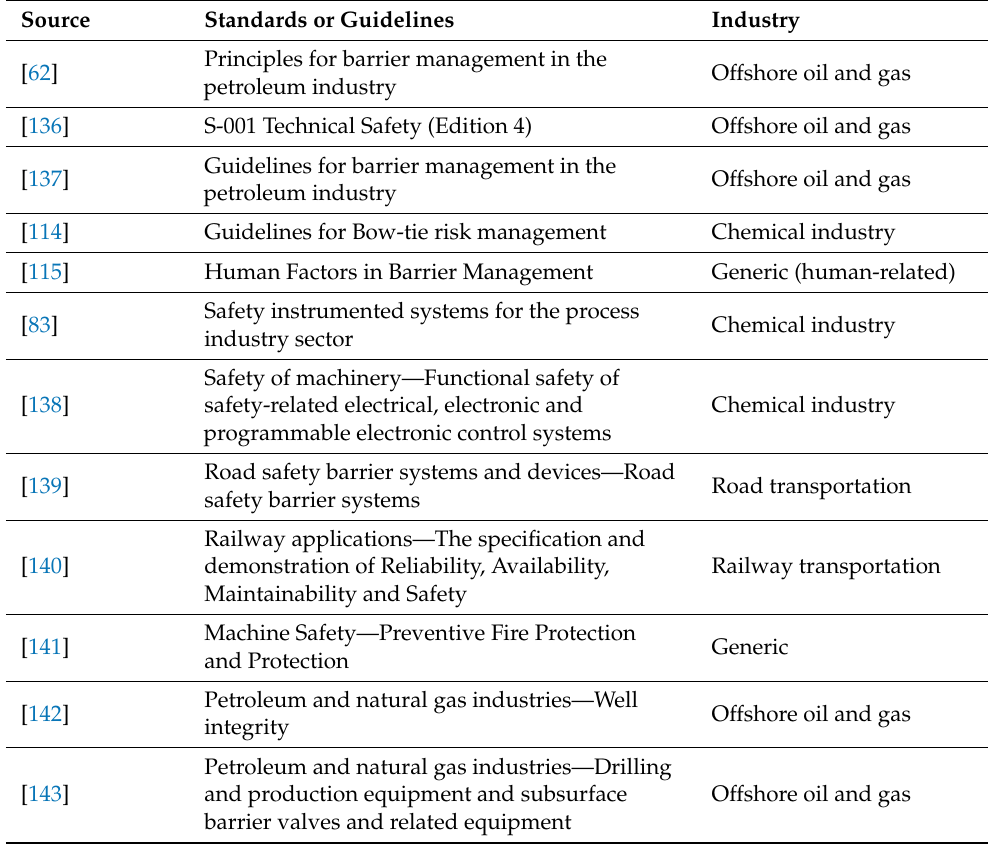
Table 6. Standards and guidelines associated with barrier